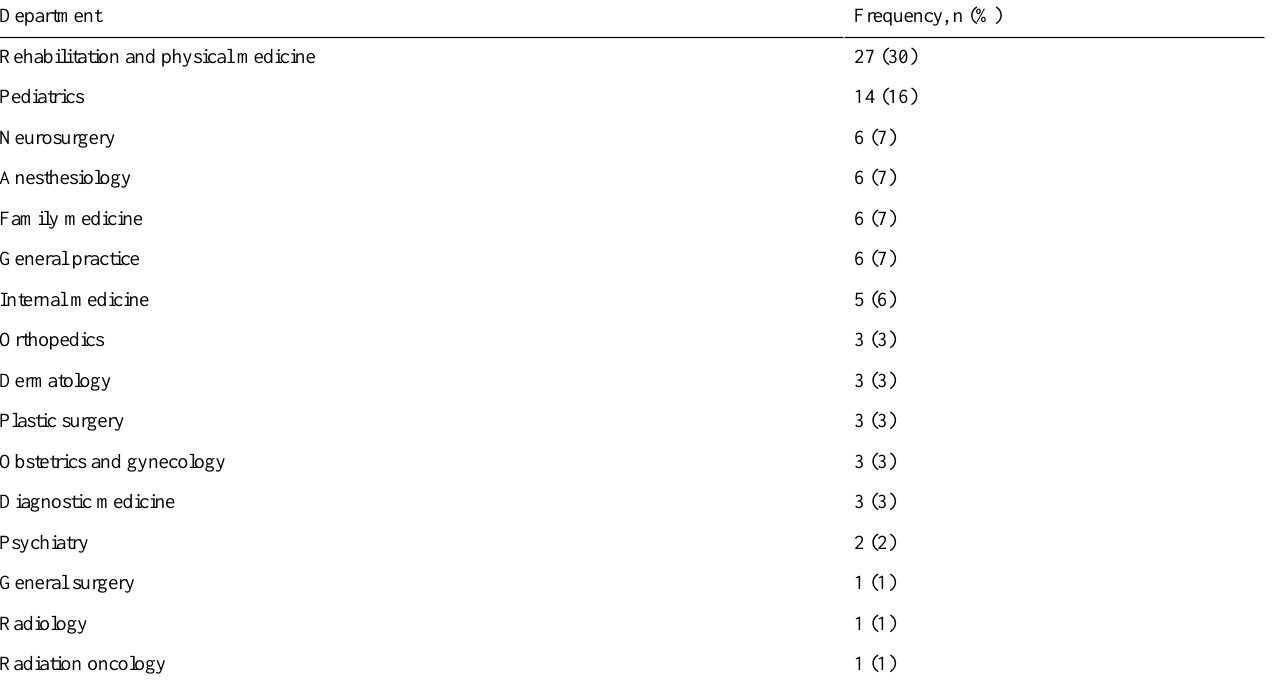
Table 2. Distribution of medical doctors across the departments that they represented